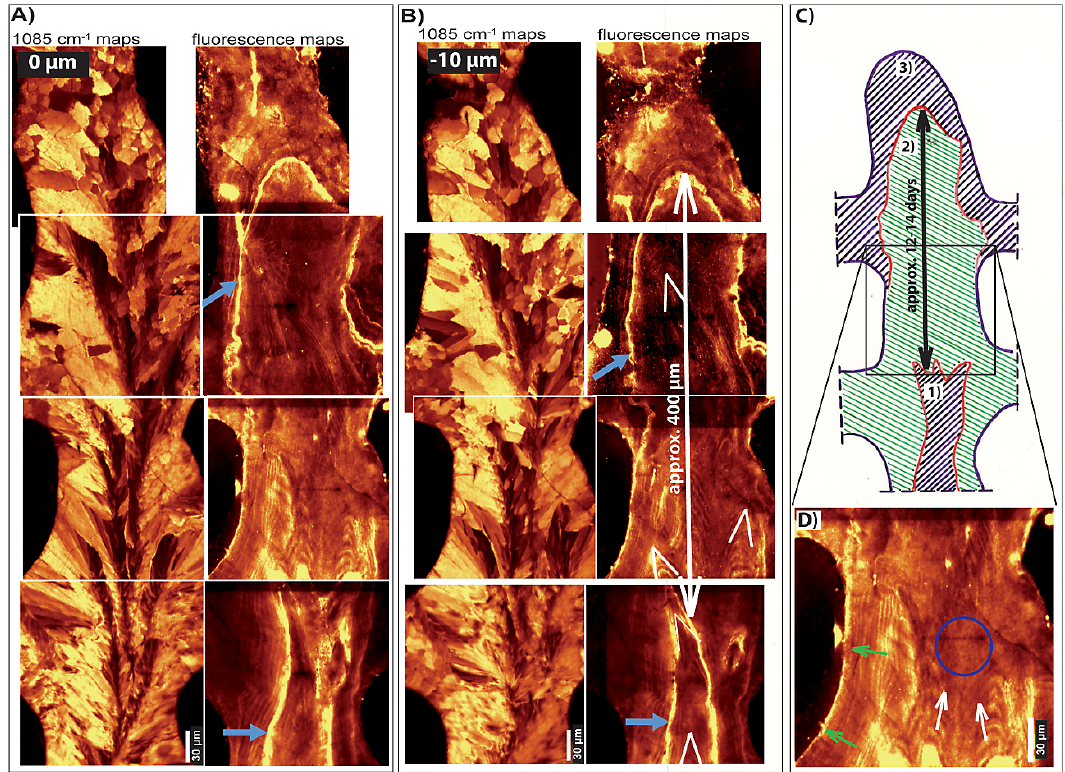
Fig. 6. ( A and B ) Raman maps in different depth levels ( A : 0µm, B : − 10µm) of intensity distribution of the symmetric stretch of arago- nite and of fluorescence are plotted on the left and right, respectively. Blue arrows indicate repeated features of organic-rich growth lines (ORGL 2) of increased fluorescence detected within fluorescence maps. White arrowheads represent the oblique traces of the position of mineralizing epithelium forming layered growth increments with a high and a low fluorescence growth line comprising one growth cycle. The scale bar within fluorescence maps displays the skeletal extension for each growth cycle. ( C and D ) Schematic representation of growth patterns mapped with confocal Raman microscopy. (C) Schematic image of cyclicity in growth representing three cycles each ending with a high fluorescence growth line (red line), which equals approx. 12–14day periodicity (daily growth rate of this specimen of ∼ 30µmd − 1 ) . (D) During each cycle different growth modes are suggested to be responsible for the three-dimensional appearance of the skeletal vertical rod. Vertical extension in the direction of the spines reflects thicker growth layers (white arrows) than in lateral growth. Lateral growth represents thickening of skeletal element (green arrows) and both lateral and vertical growth potentially is associated with different growth rates. Blue circle marks an area of a not clearly visible banding pattern where the skeleton was potentially sectioned parallel to the position of the growth